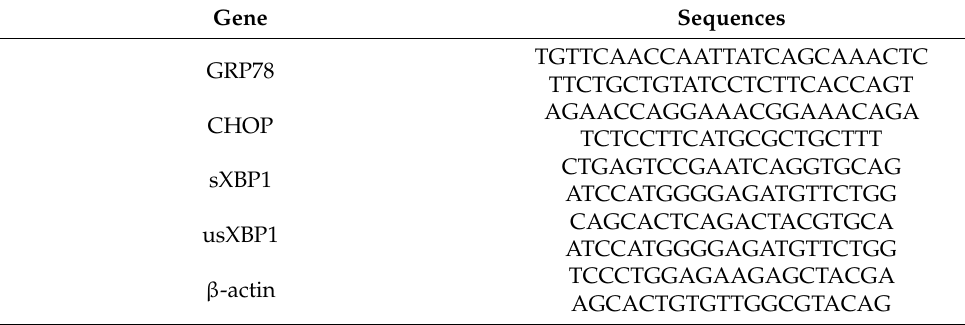
Table 1. List of primers used in qRT-PCR